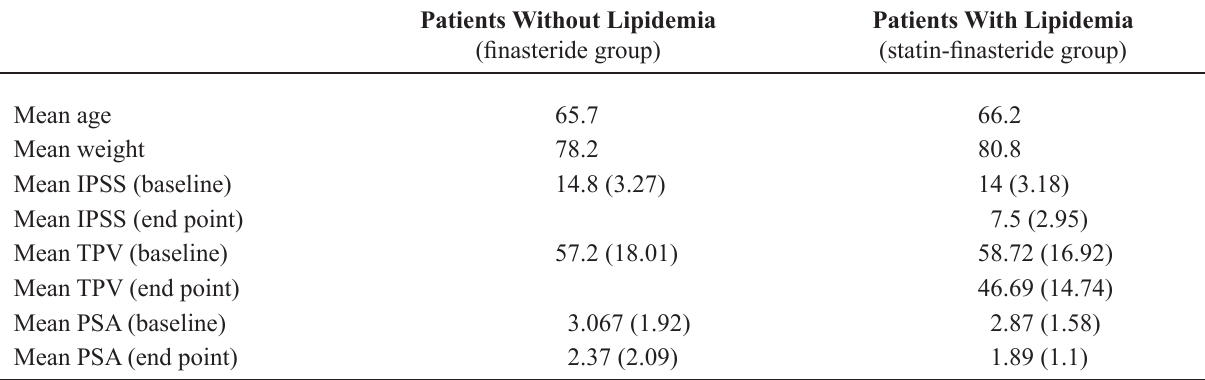
Table 1 – Patient